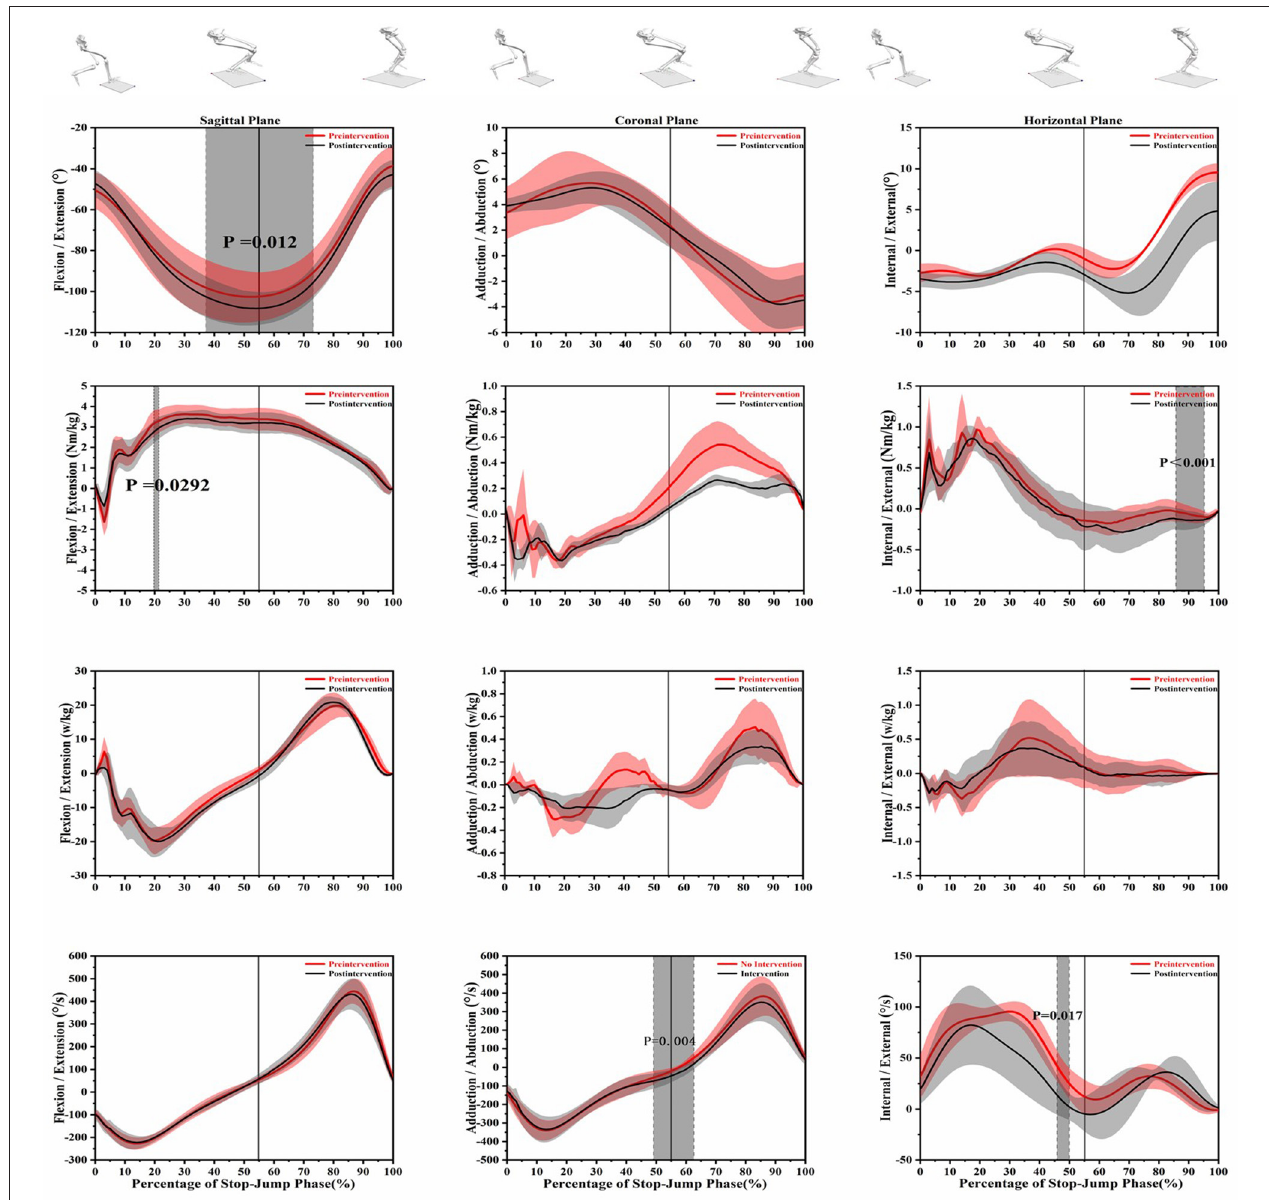
FIGURE 3 | The results of statistical parametric mapping (SPM) pre and post video tasks depicting the mean angle, moment, power, angular velocity, with standard error in knee sagittal coronal, and transverse planes. The solid line at 55% represents the time of maximum knee flexation. The gray region indicates a statistical differences ( p <